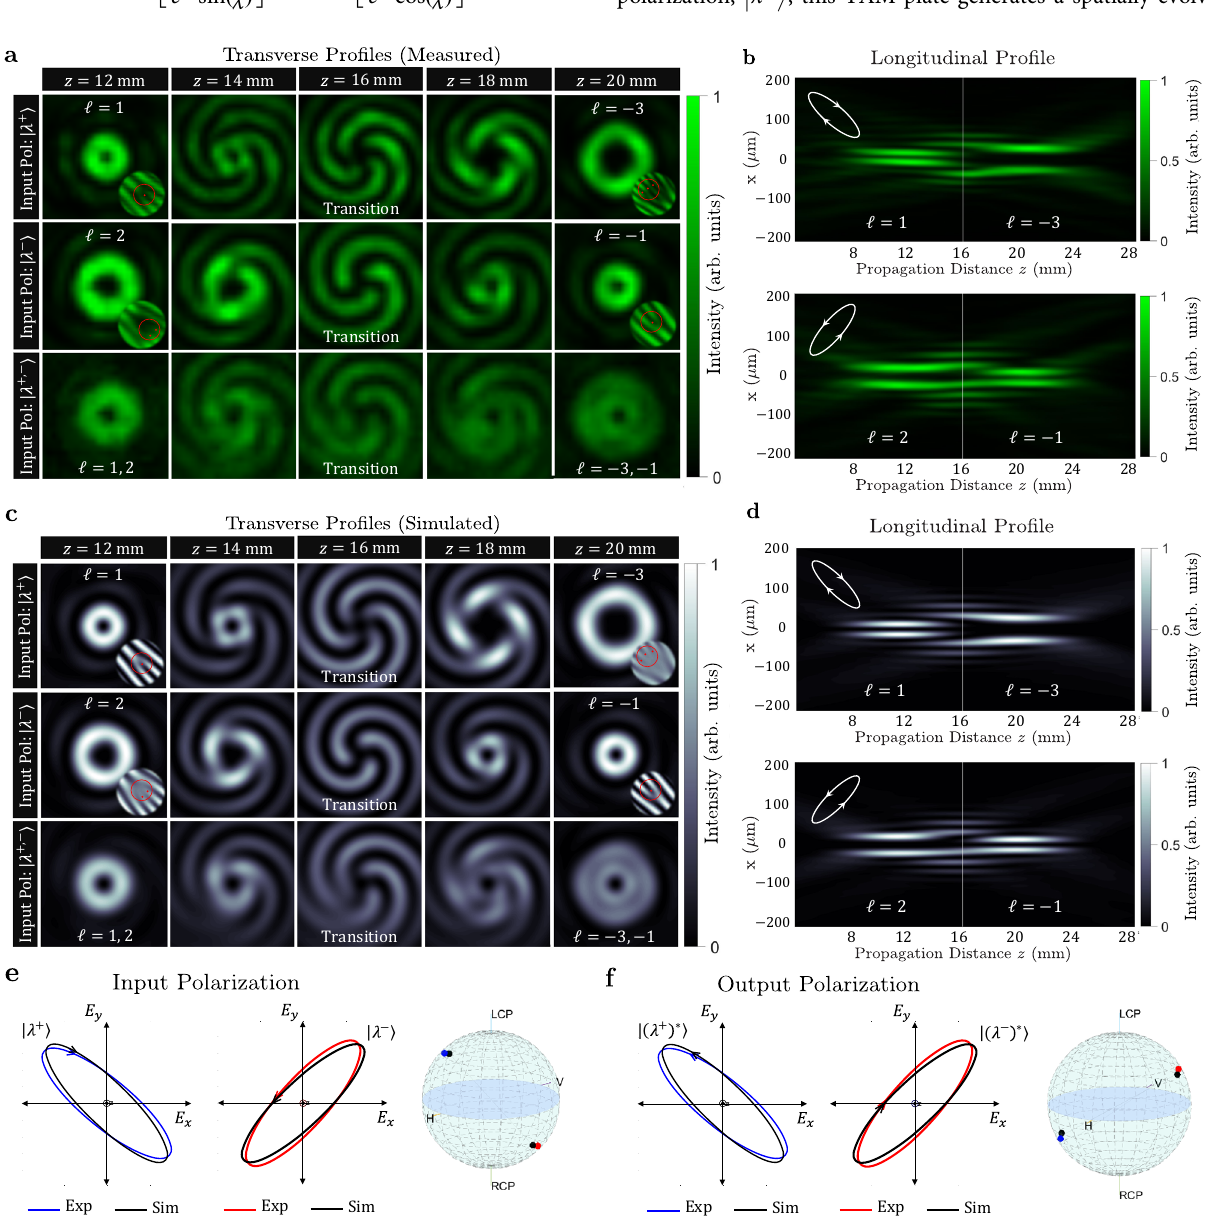
Fig. 3 Polarization-switchable TAM plate with elliptical eigen polarizations. a Measured output transverse intensity pro fi les generated by the device in (cid:1) (cid:3) (cid:1) response to λ þ and λ (cid:2) j i polarizations, in addition to an equal weight of the two. The device responds to λ þ changing its charge from ℓ = 1 to ℓ = − 3 as it propagates along the z -direction, whereas for the orthogonal polarization, λ (cid:2) j i , a different vortex evolving from ℓ = 2 to ℓ = − 1 is produced. The insets depict the topological phase dislocations obtained from an interferomteric measurement with a tilted Gaussian beam. At each z -plane, a mixture of the two OAM states can be generated by changing the weights assigned to the eigen polarizations incident on the device. b Measured longitudinal intensity pro fi le at the output of the device under the two orthogonal incident polarizations, λ þ generation of two distinct vortices with spatially evolving topological charges. c , d Simulated data corresponding to the measurements in a , b . e , f Measured and designed eigen polarizations at the input ( e ) and output ( f ) of the device. The chirality of incident light is inverted upon interacting with the device. Spatial dynamics of these beams can be found in Supplementary Movies 1 and